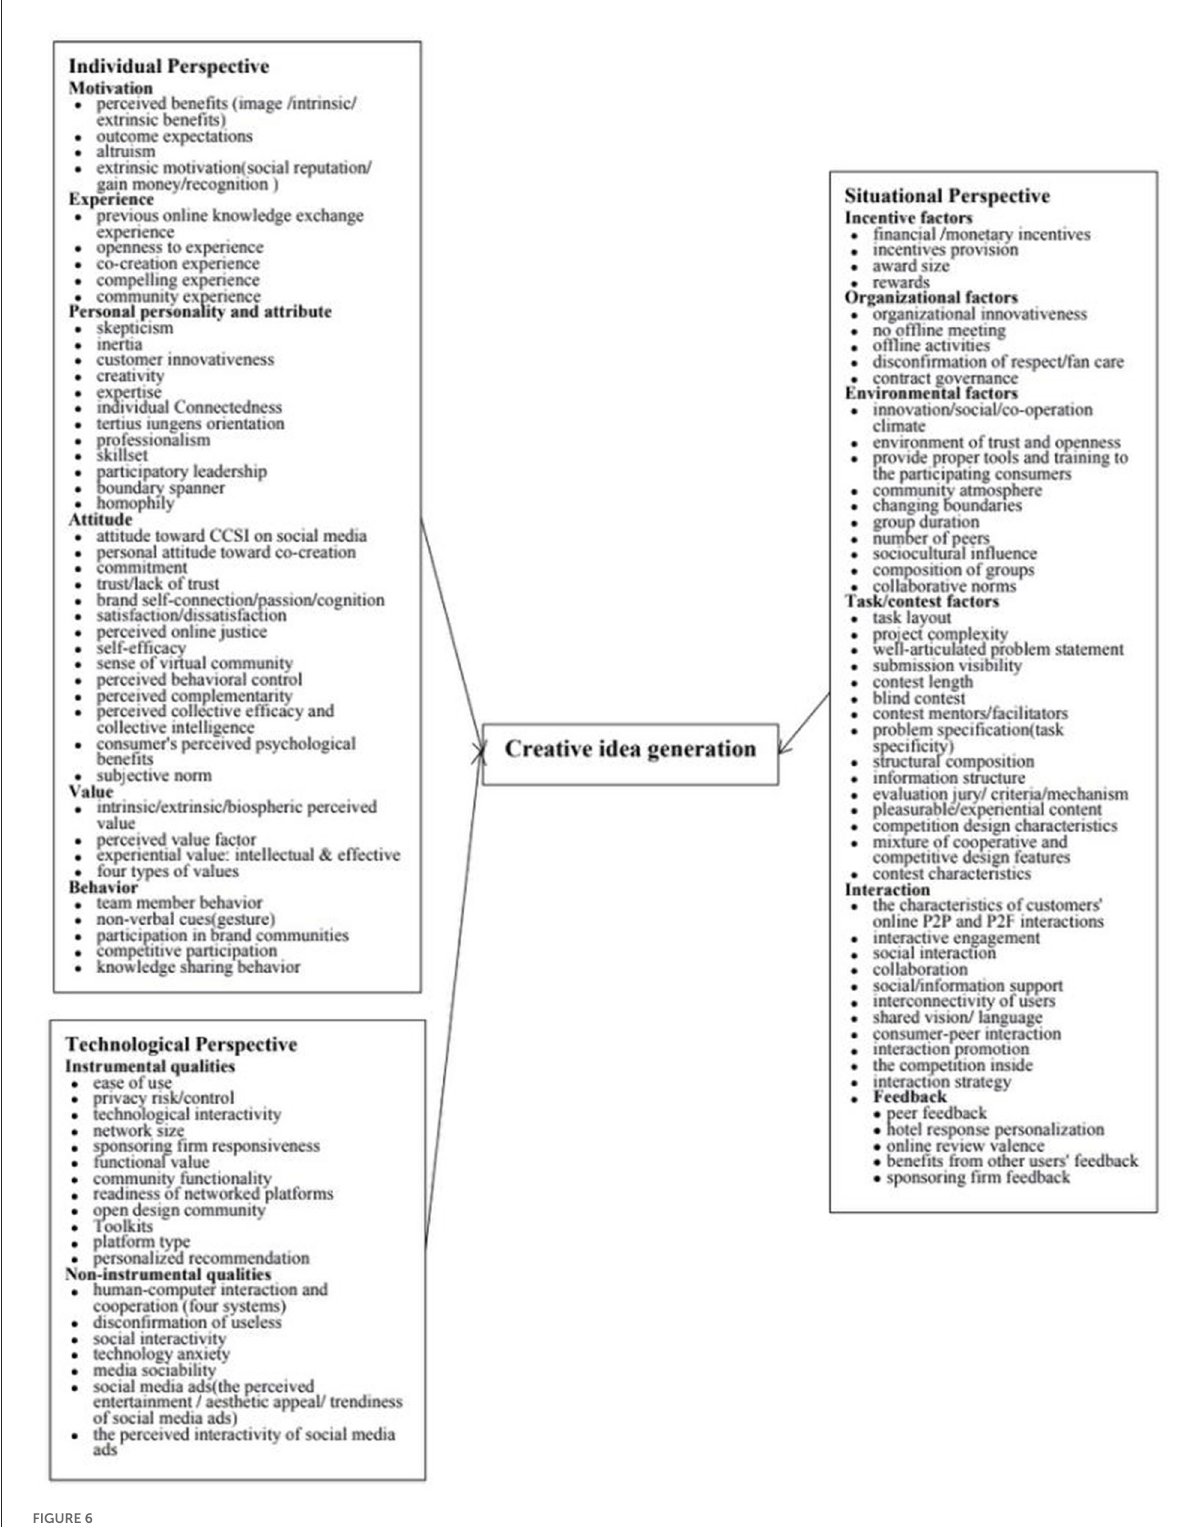
FIGURE6 Influencing factors of online creative ideas